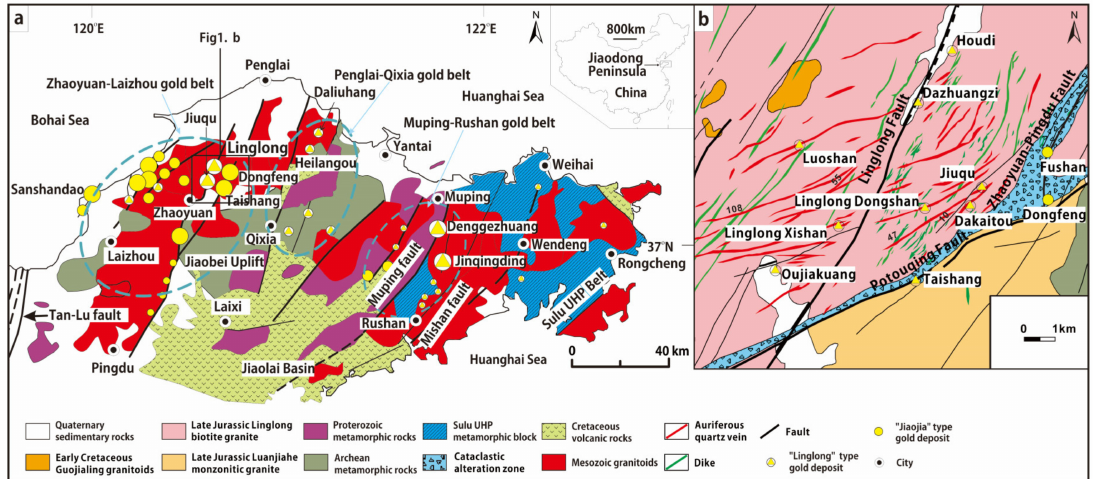
Figure 1. ( a ) A simplified geological map of the Jiaodong gold province, which is located in the eastern China (peninsula) (inset), with spatial distribution of the gold deposits. ( b ) A geological map of the Linglong goldfield with locations of known mining camps. Filled circles represent disseminated ore deposits; circles filled with a triangle represent vein-type deposits. Symbol sizes are proportional to gold